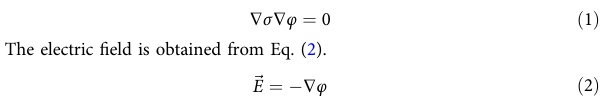
Experiment 3: Epidural TI current steering in intact rats . To determine how to steerably activate the diaphragm without moving electrodes, we tested two